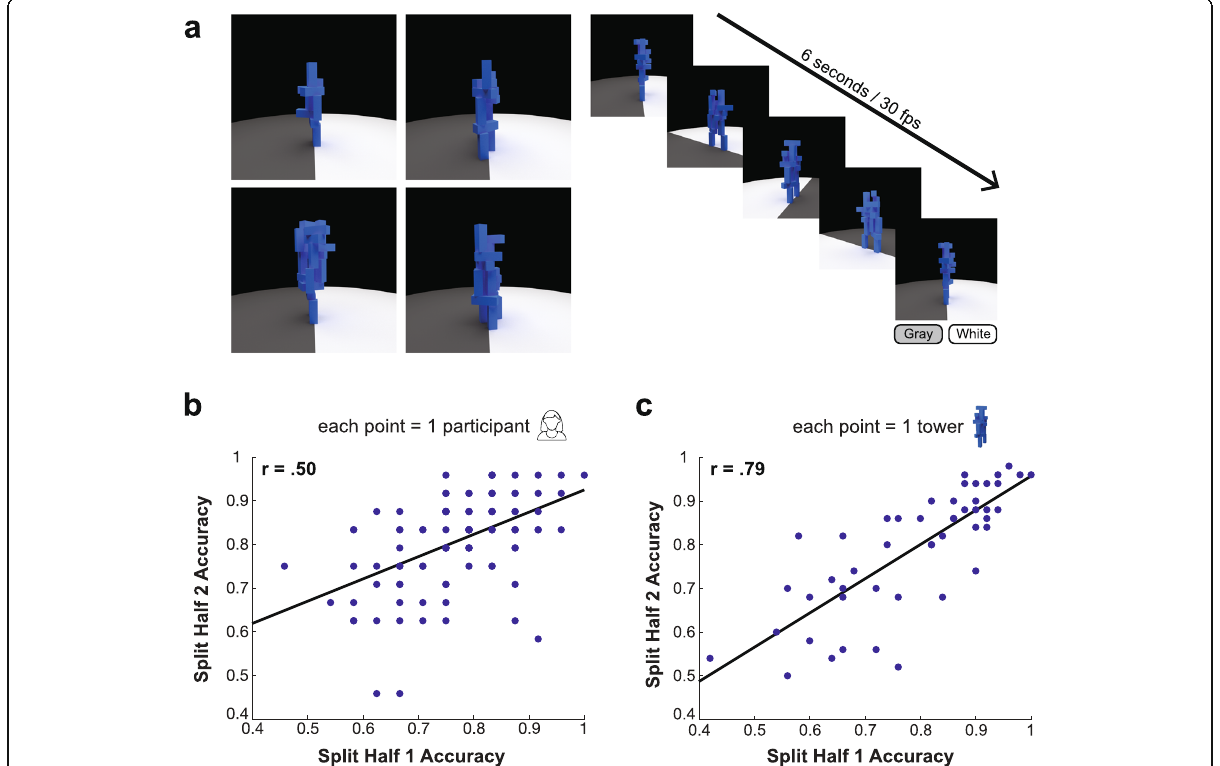
Fig. 1 Reliable individual differences in the Unstable Towers task. a Left, examples of unstable tower stimuli used in the task. Right, each tower was displayed in a 6 s video at 30 frames per second that circled the tower in 360°. After viewing each video, participants reported which side of the platform the majority of blocks would land on - gray or white. b Performance on the towers task was reliable across independent sets of stimuli. We split the set of towers into two halves (see “ Methods ” ) and computed performance in the two stimulus sets (each plotted point is one participant). Performance across the split halves was significantly correlated ( r (98)= 0.50, p < .001) and spanned the range from near chance to near perfect, indicating that our version of the towers task is a reliable and sensitive measure of individual differences. c The difficulty of assessing each tower was reliable across independent sets of observers. We split the participants into two groups and computed performance for each tower stimulus within each group (plotted points are individual towers). Accuracy was highly significantly correlated across split halves ( r (98) = .79, p < .001) and spanned a broad range of